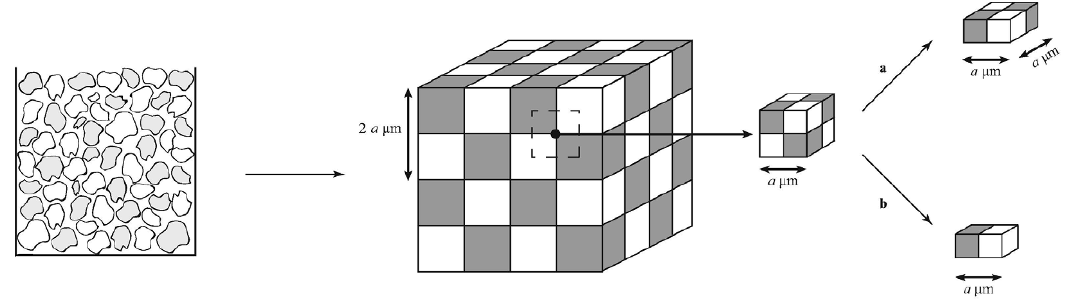
Figure 1. Synthesis spaces. (a) The two-dimensional model: V = (0, a ) × (0, a ); a =1 ( m m) for the sol-gel method and a = ( m m) for the solid-state method; (b) the one-dimensional model: V = (0, a ) ; a =1 ( m m) for the sol-gel method and a =10 ( m m) for the solid-state